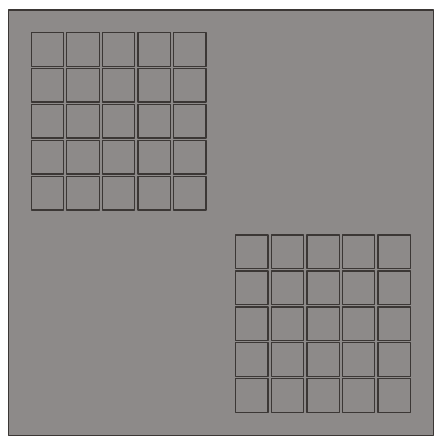
Figure 7: The measured S